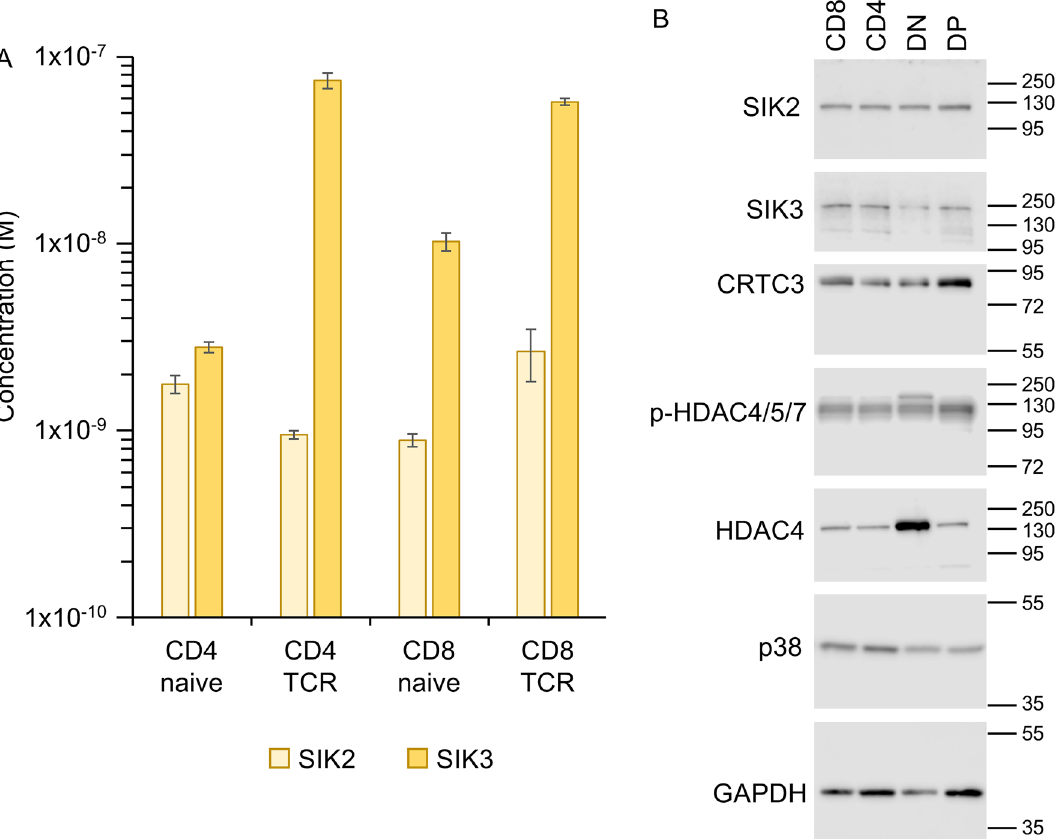
Figure 1. SIK levels in T cell subsets. ( A ) Naïve CD4 and CD8 T cells were isolated by FACS and subject to TMT labelled proteomic analysis as described in 33 . For ex vivo stimulations of the TCR, GP33 (glycoprotein amino acids 33–41), 20 ng/ml IL-2 and 2 ng/ml IL-12 were used to stimulate CD8 cells from P14 mice. OVA peptide loaded onto antigen presenting cells was used to stimulate CD4 cells from OT-II mice as described in 33 . Graphs show mean and standard deviation for SIK2 and SIK3. SIK1 was not detected. For CD4 cells, data are from independent preparations from 3 mice per genotype and for CD8 cells from 6 mice per genotype. Data is derived from Howden et al. 2019, Nat. Immunol. 20, 1542–1554 33 . ( B ) Thy1 +ve thymocytes pooled from 5 mice were sorted based on CD4 and CD8 expression into CD8 single positive, CD4 single positive, double negative (DN) and CD4/8 double positive (DP) cells by FACS. 5 μg of lysate was separated by SDS-PAGE and blotted using the indicated antibodies. Molecular weight markers are shown, with weights in